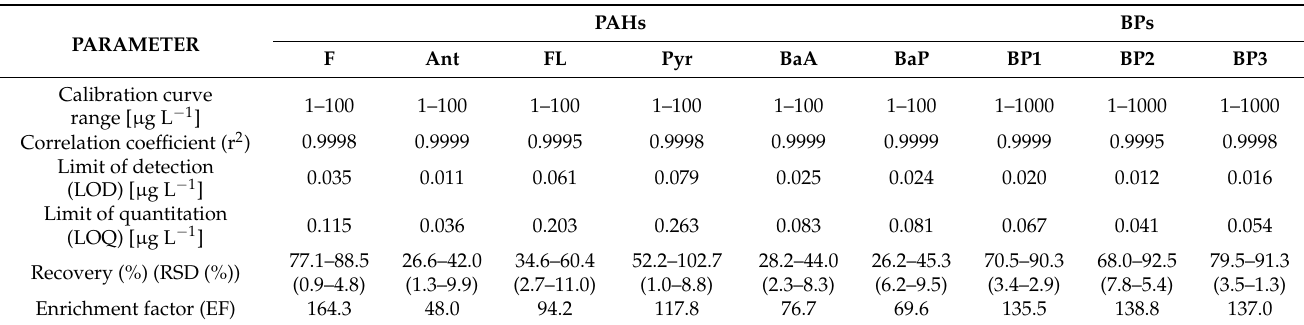
Table 2. Validation parameters for target PAHs and BPs determination using the MR in situ IL-DLLM method.